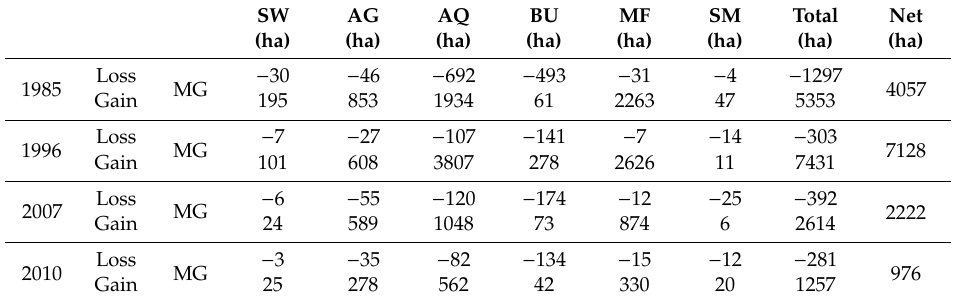
Table 3. Conversions among mangroves and other land covers in the whole coastal zone of